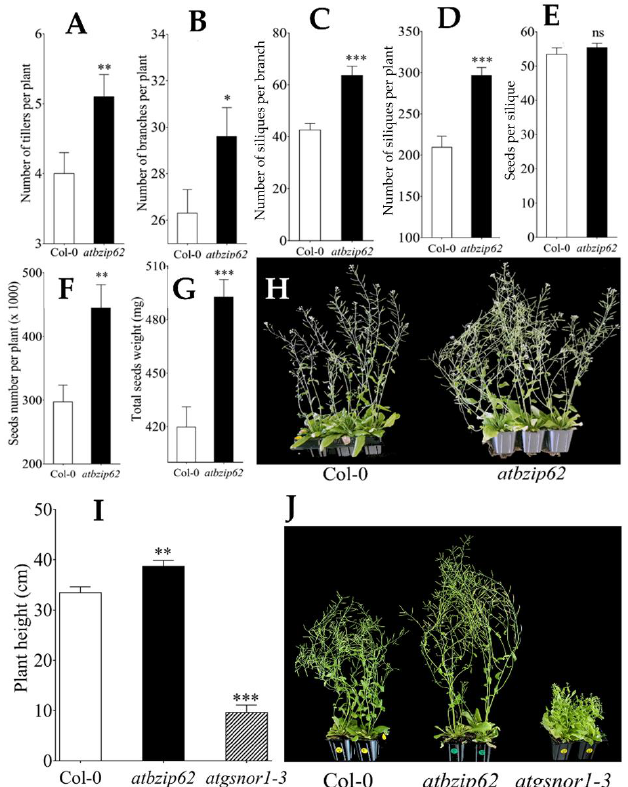
Figure 1. Morphology of atbzip62 plants grown under normal conditions. ( A ) Number of tillers per plant, ( B ) number of branches per plant, ( C ) number of siliques per branch, ( D ) number of siliques per plant, ( E ) number of number seeds per silique, ( F ) number of seeds per plant, ( G ) seeds weight per plant, ( H ) phenotype of Arabidopsis atbzip62 showing an increased number of tillers com- pared to Col-0 wild type, ( I ) plant height, and ( J ) phenotype of atbzip62 plants showing an in- creased in plant height compared to Col-0 and atgsnor1-3 . ***p <0.001, **p <0.01, *p <0.05, ns non- significant.